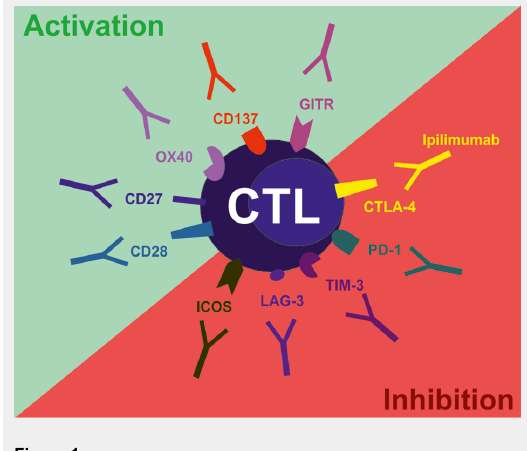
Examples of co-stimulatory and co-inhibitory molecules on T cells suitable for targeting with agonistic and blocking antibodies, respectively. CTLA-4, cytotoxic T lymphocyte antigen-4; PD-1, programmed cell death 1; TIM-3, T cell immunoglobulin and mucin domain-containing protein 3; LAG-3, lymphocyte activation gene 3; ICOS, inducible T cell co-stimulator; GITR, glucocorticoid-induced TNF family related gene; CD, cluster of